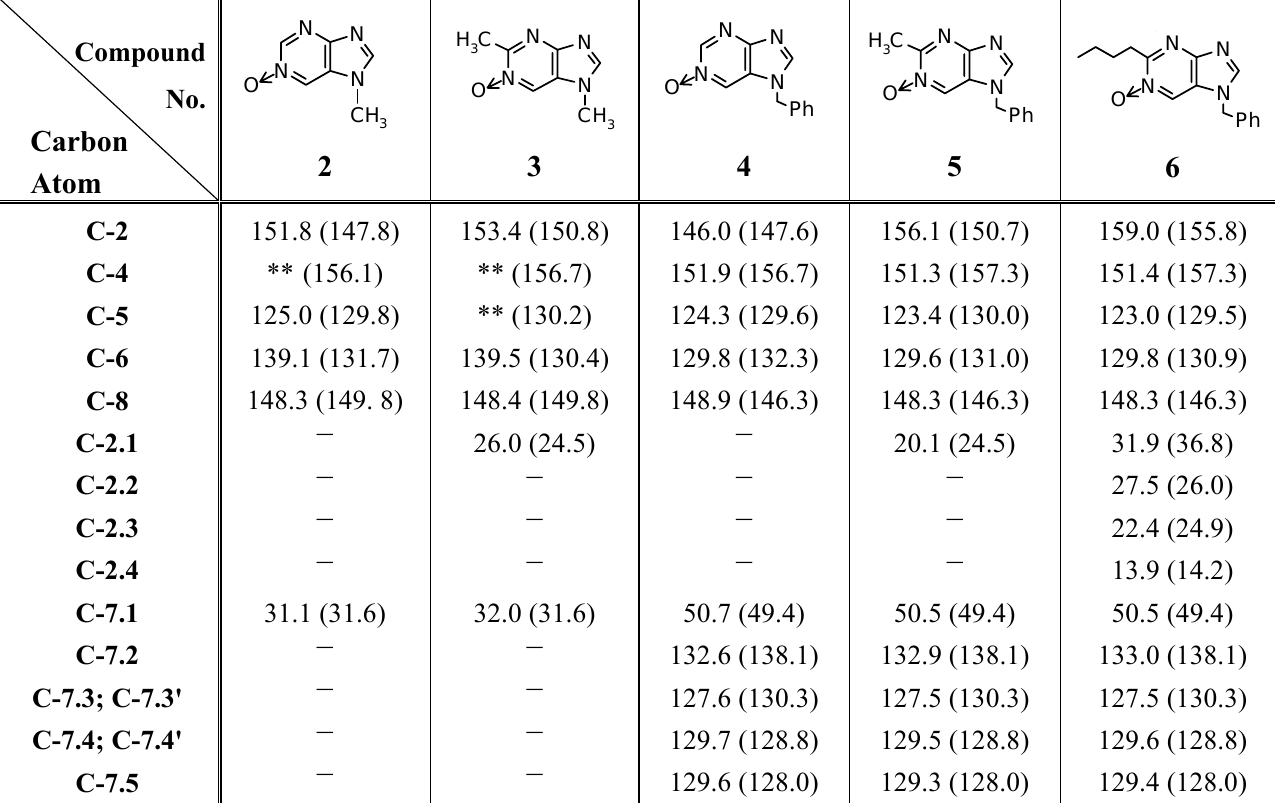
*; 75 MHz); calculated data in 3